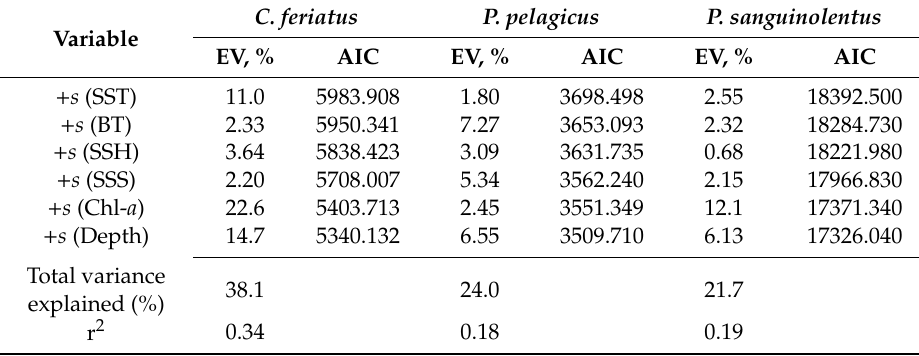
Table 1. Explained one variable model variances (EV, %) of observed catch rates in the generalized additive models with environmental variables sequentially added (first to last) for C. feriatus , P. pelagicus , and P. sanguinolentus in the TS (all p < 0.01). The determination coe ffi cient (r 2 ) represented the predictive performance of model predictability.